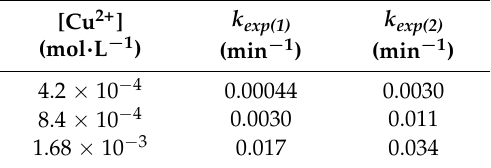
Table 3. Effect of copper concentration: values of the experimental constants.